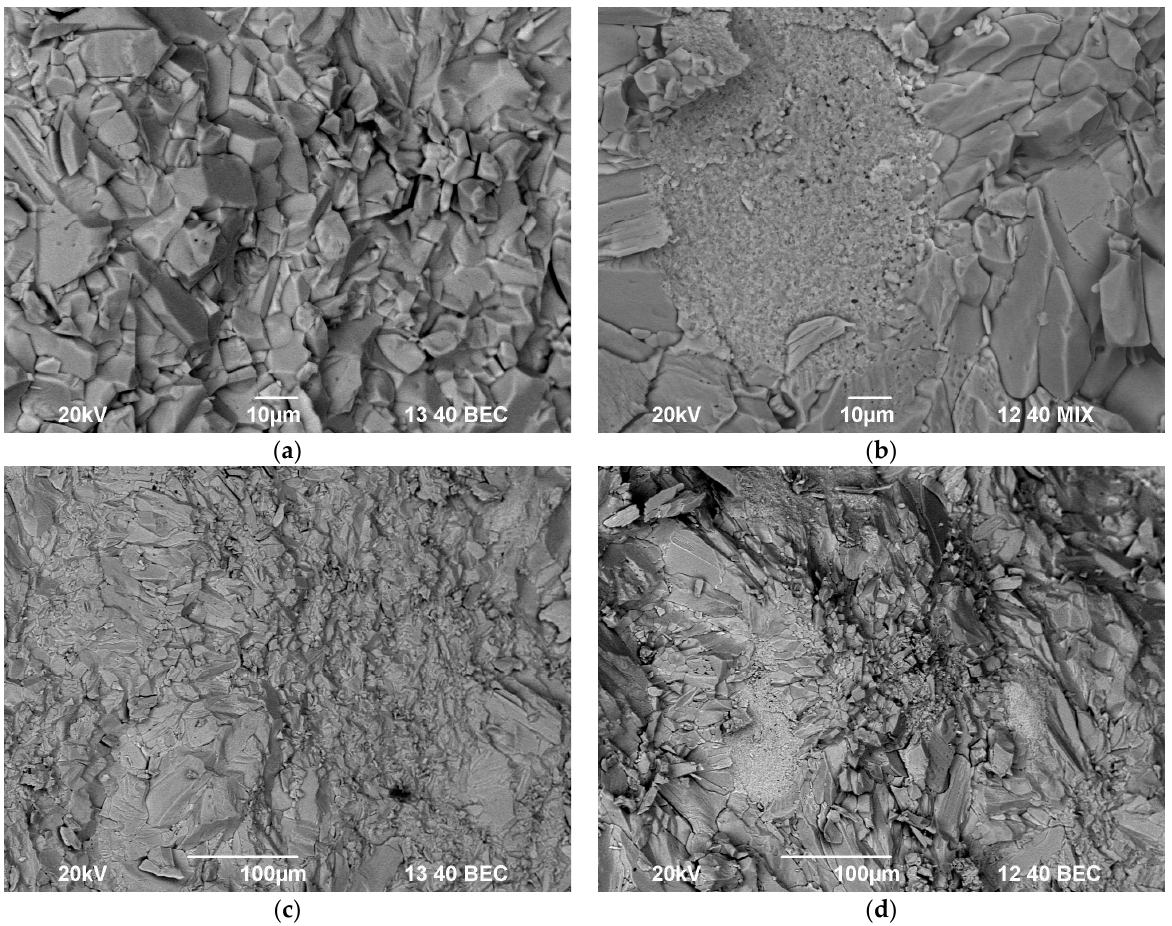
Figure 5. Microstructure of the YPO 4 :Gd ceramics obtained with SPS. SEM of the samples fracture surface.